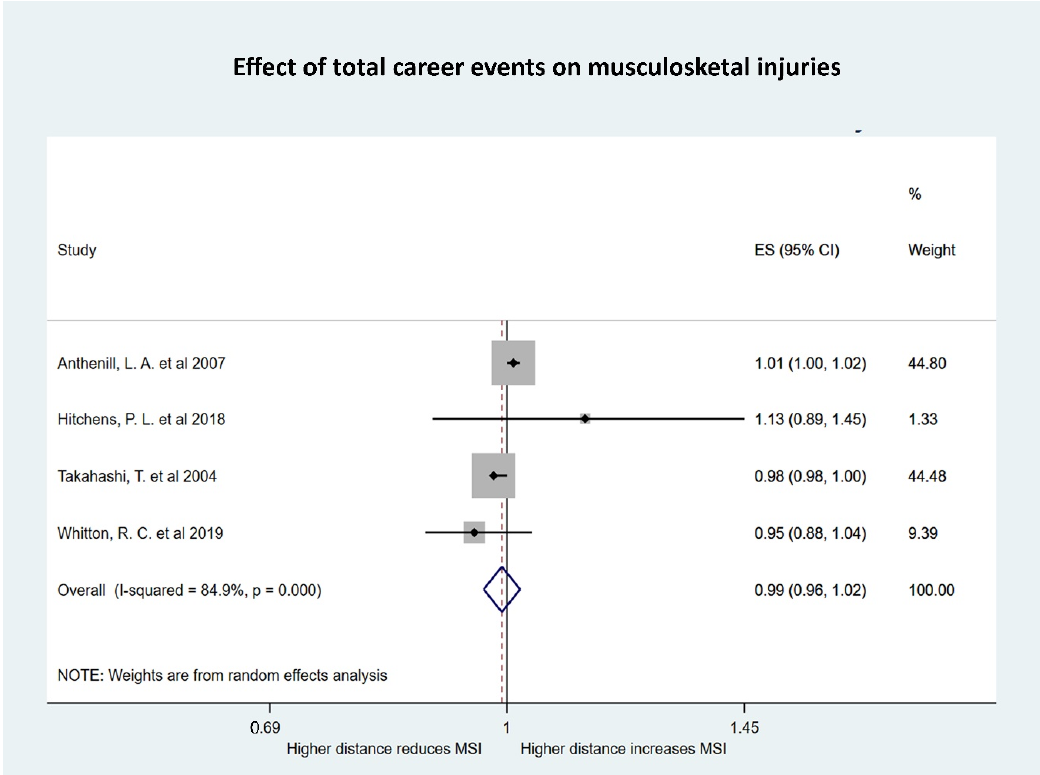
Figure 6. Forest plot of the effect of the total number of accumulated high-speed exercise (HSE) events on musculoskeletal injuries (MSI) in Thoroughbred racehorses with effect size (ES) reported as odds per increase of one high-speed exercise event.